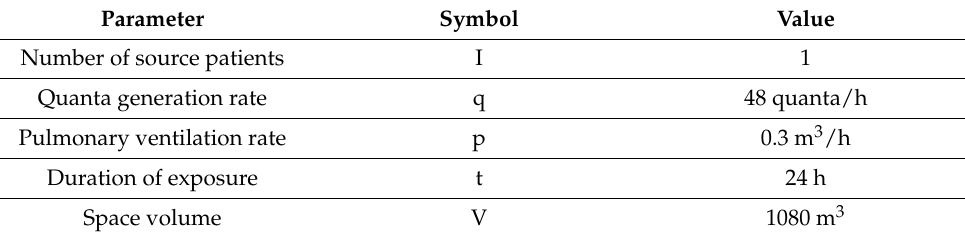
Table 1. List of the parameter’s values used in the Wells-Riley equation.